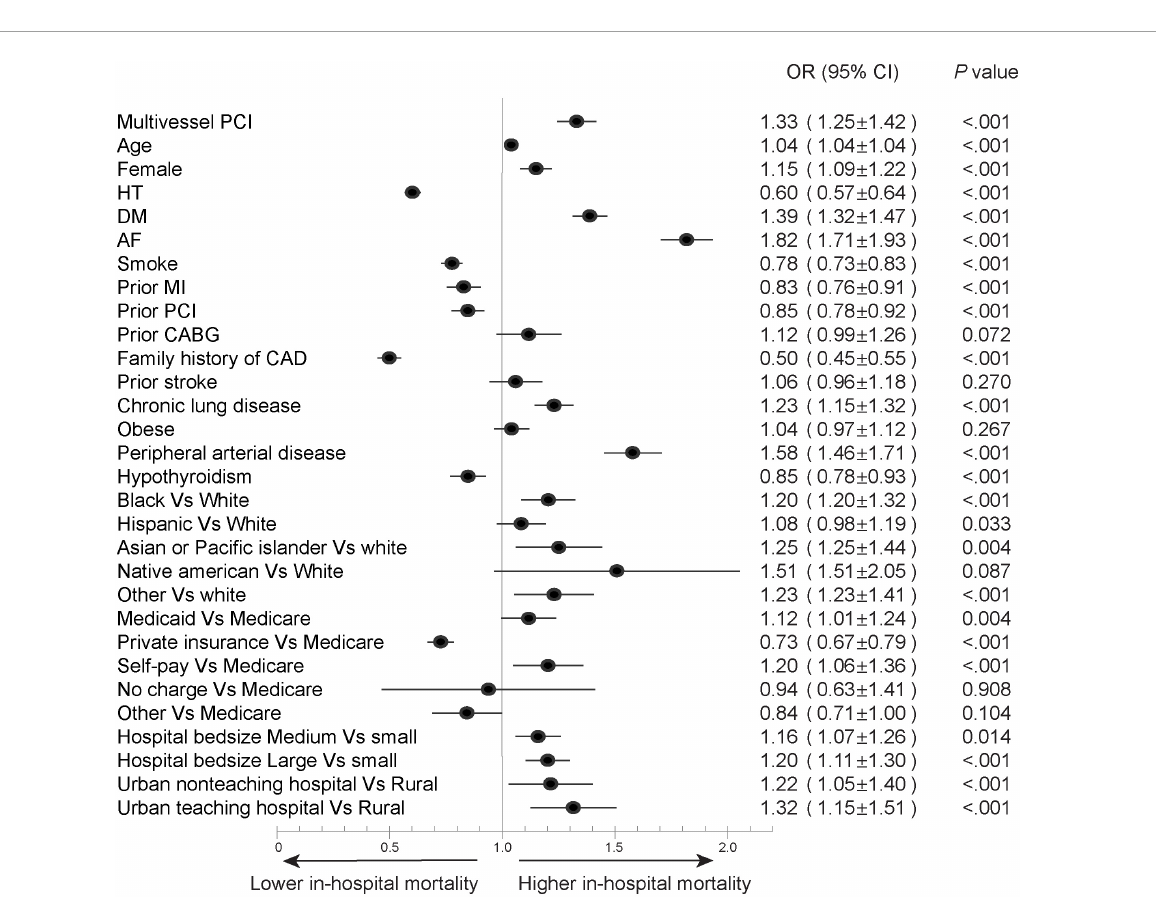
FIGURE3 Forest plot of multivariable regression analysis to predict in-hospital mortality in overall STEMI cohort. AF, atrial fibrillation; CABG, coronary artery bypass graft; CAD, coronary artery disease; DM, diabetes mellitus; HT, hypertension; MI, myocardial infarction; PCI, percutaneous coronary